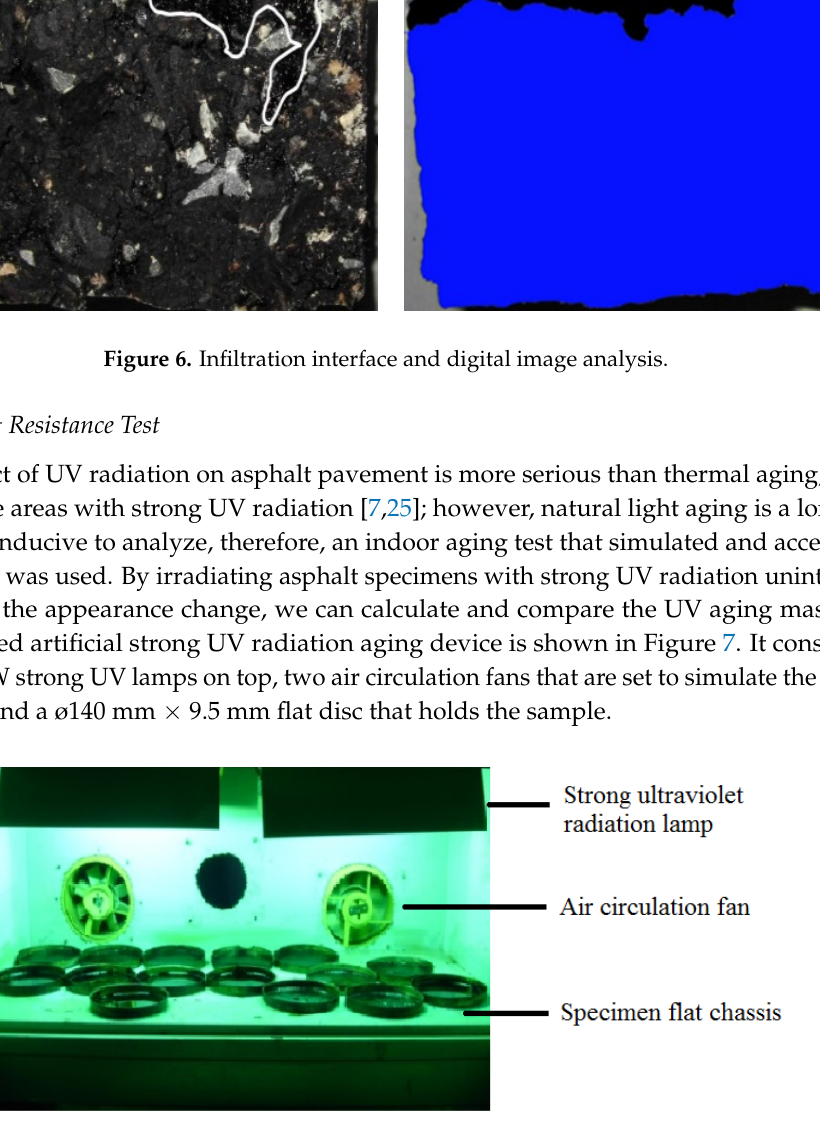
Figure 7. Artificial strong UV radiation aging test.